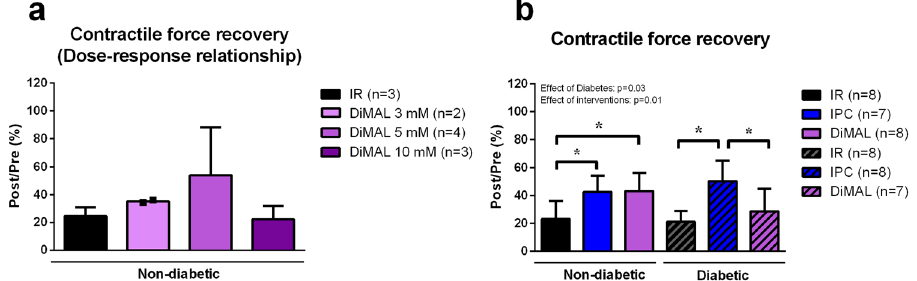
Figure 4. Human study – Dose-response relationship and contractile force recovery. Dose-response relationship between DiMAL and contractile force recovery in non-diabetic human atrial trabeculae ( a ) and contractile force recovery of non-diabetic and diabetic human atrial trabeculae given as a ratio of contractile force in the reperfusion compared to the pre-ischemic value ( b ). IR: Ischemia reperfusion, DiMAL: Dimethyl Malonate, IPC: Ischemic preconditioning. Data are mean ± SD. * P < 0.05 between indicated groups. P-values at the top indicate overall effect of diabetes and interventions by two-way ANOVA,